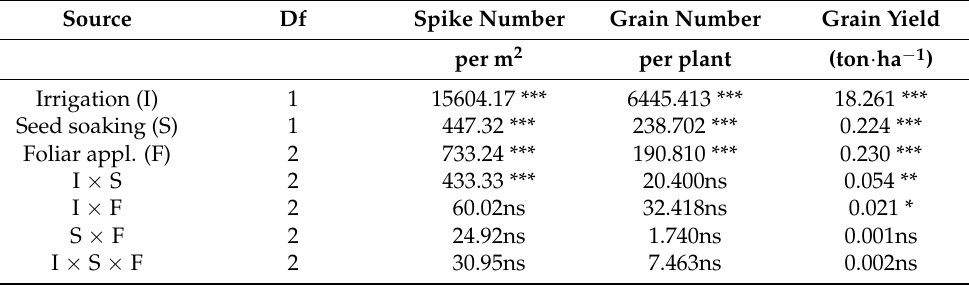
Table 7. Analysis of variance (mean square) of grain yield and its components.